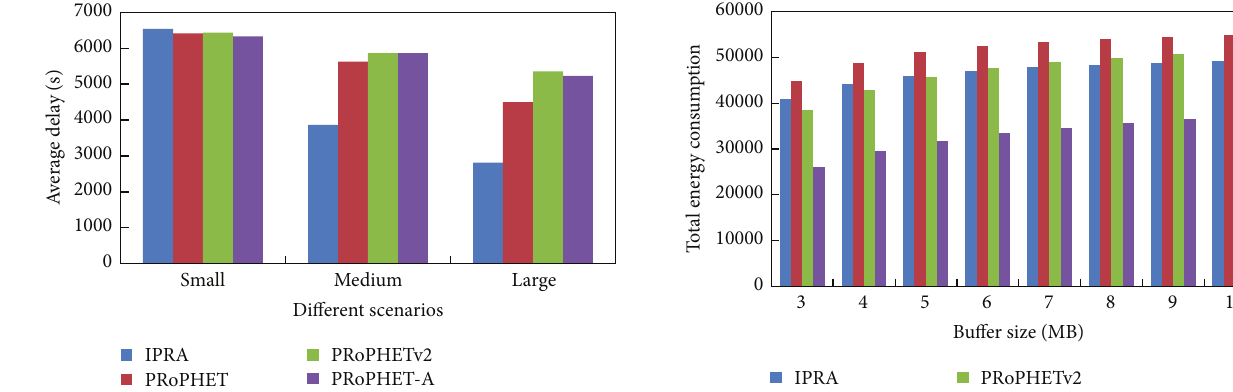
Figure 17: Total energy consumption (TEC) versus buffer size.